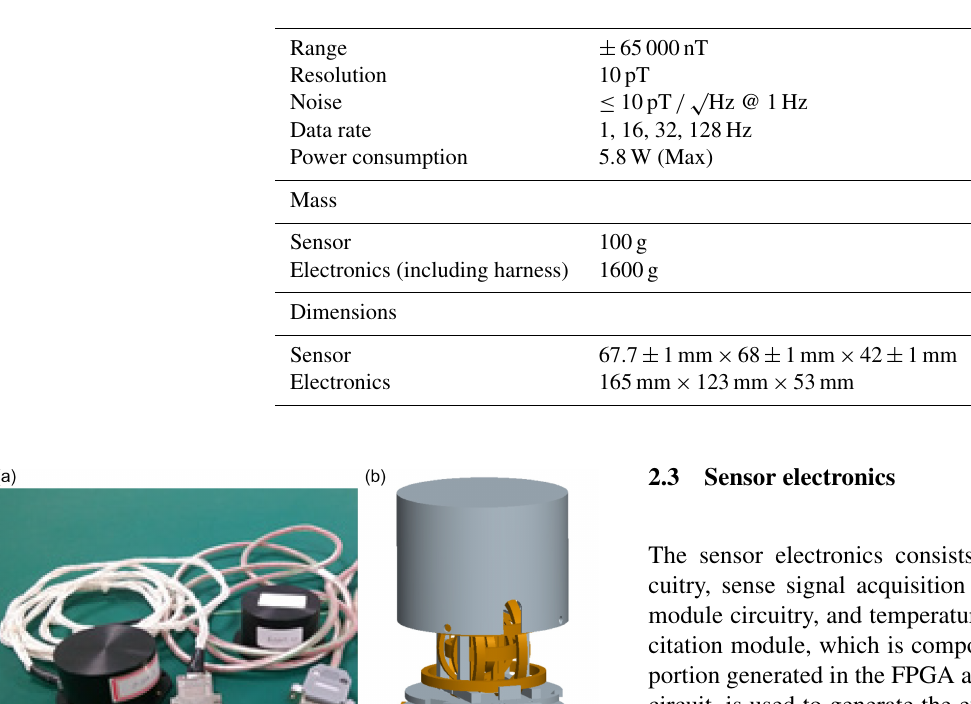
Table 1. The instrument parameters of the magnetometers on board the LOPS.